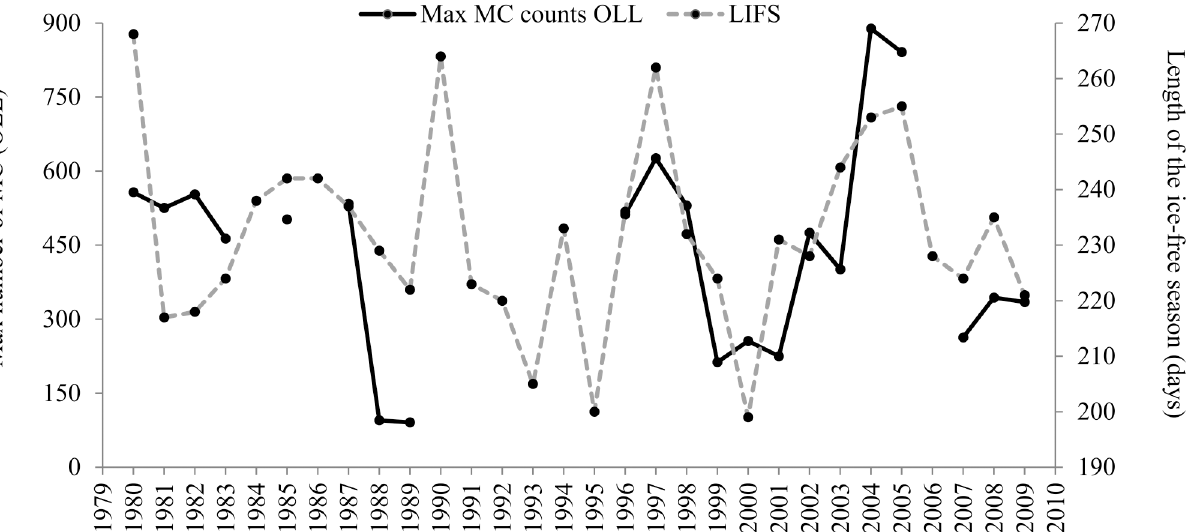
Fig 7. Temporal trends of mother-calf pairs and previous summer conditions at the Bering Sea. Maximum counts of mother-calf pairs (MC) at Ojo de Liebre Lagoon (OLL) during the month of February and length of the ice-free season (LIFS) of the previous feeding season at the Bering Sea.